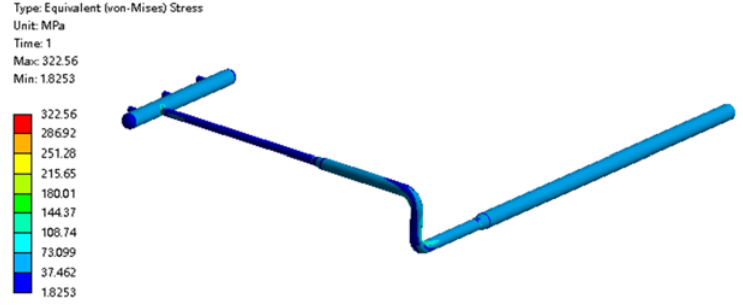
Figure 23. Cloud diagram of pipe stress distribution at − 1 °C.